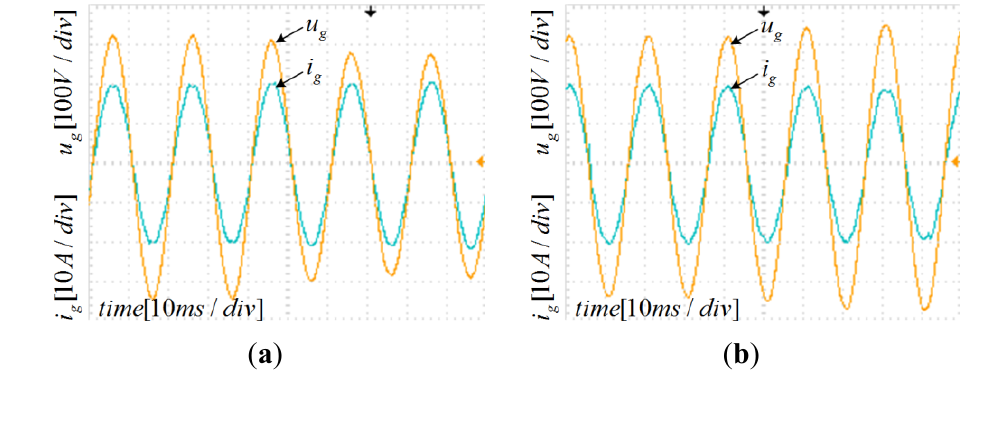
Figure 19. Grid voltage and injected current at full load with nominal parameters: experimental results. ( a ) Grid voltage sag; ( b ) grid voltage